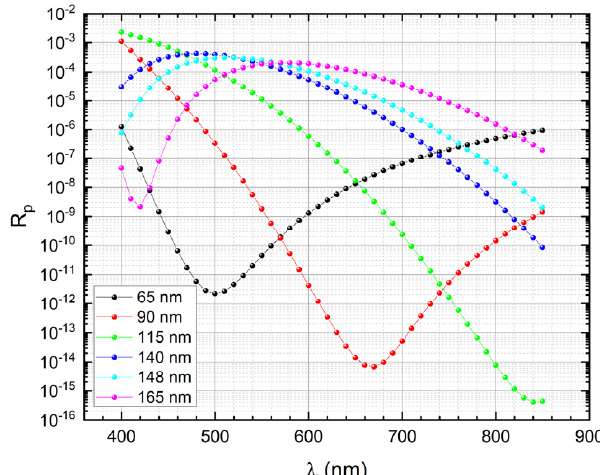
Figure 5. Simulated p—polarization reflectance as a function of wavelength for PQEDs mounted in trap configuration with an angle of 15° between the diodes. In this configuration the light beam undergoes 7 reflections: one at 0° degree and two reflections at 15°, 30°, and 45°. The reflectance is reported for six different thicknesses of the SiN x .